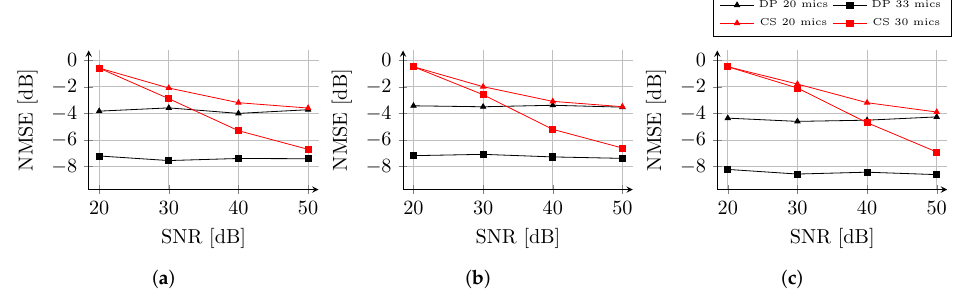
Figure 7. NMSE of the RIR reconstruction as a function of the SNR for rooms Balder ( a ), Freja ( b ) and Munin ( c ) from [20]. The RIR interpolations are obtained using 20 (triangle marks) or 33 (square marks) microphones. Adapted from Ref. [20], with permission from Elsevier